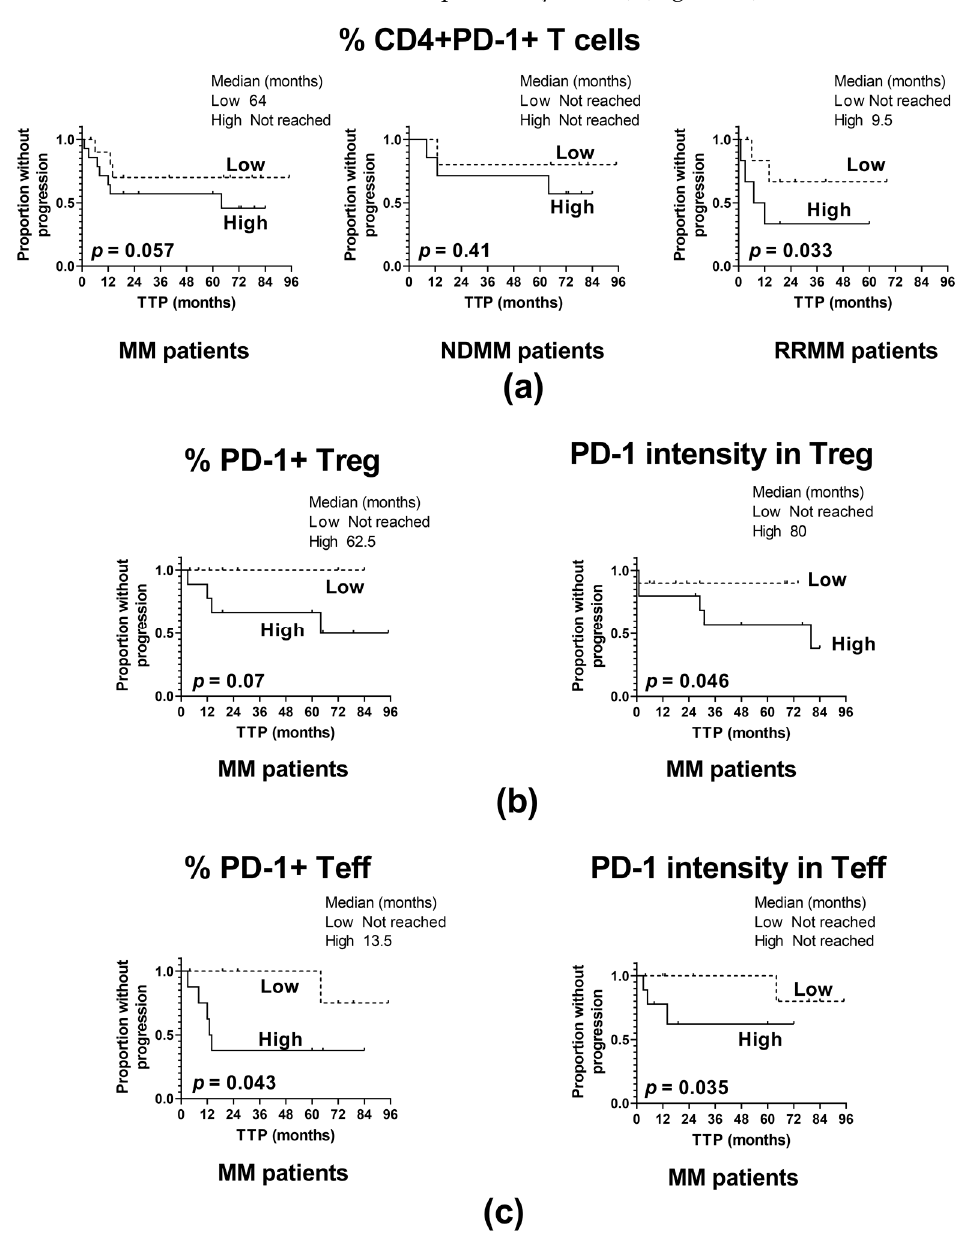
Figure 4. Influence of PD-1 expression on the time to progression (TTP). ( a ) TTP in patients with high and low frequency of PD-1 positive CD4 + T cells identified as >median and ≤ median values, respectively, in the whole patient cohort (MM) (n = 40) and patient subgroups (NDMM and RRMM) (n = 26 and n = 14, respectively). ( b ) TTP in patients with high and low PD-1 expression in Treg cells (shown as the frequency of PD-1 + Treg cells and as PD-1 fluorescence intensity in Treg), identified as >median and ≤ median values, respectively, in the whole patient cohort (MM) (n = 40). ( c ) TTP in patients with high and low expression of PD-1 in Teff cells (shown as frequency of PD-1 + Teff and as PD-1 fluorescence intensity in Teff) identified as >median and ≤ median values, respectively, in the whole patient cohort (MM) (n = 40). The log-rank test was performed for the Kaplan–Meier